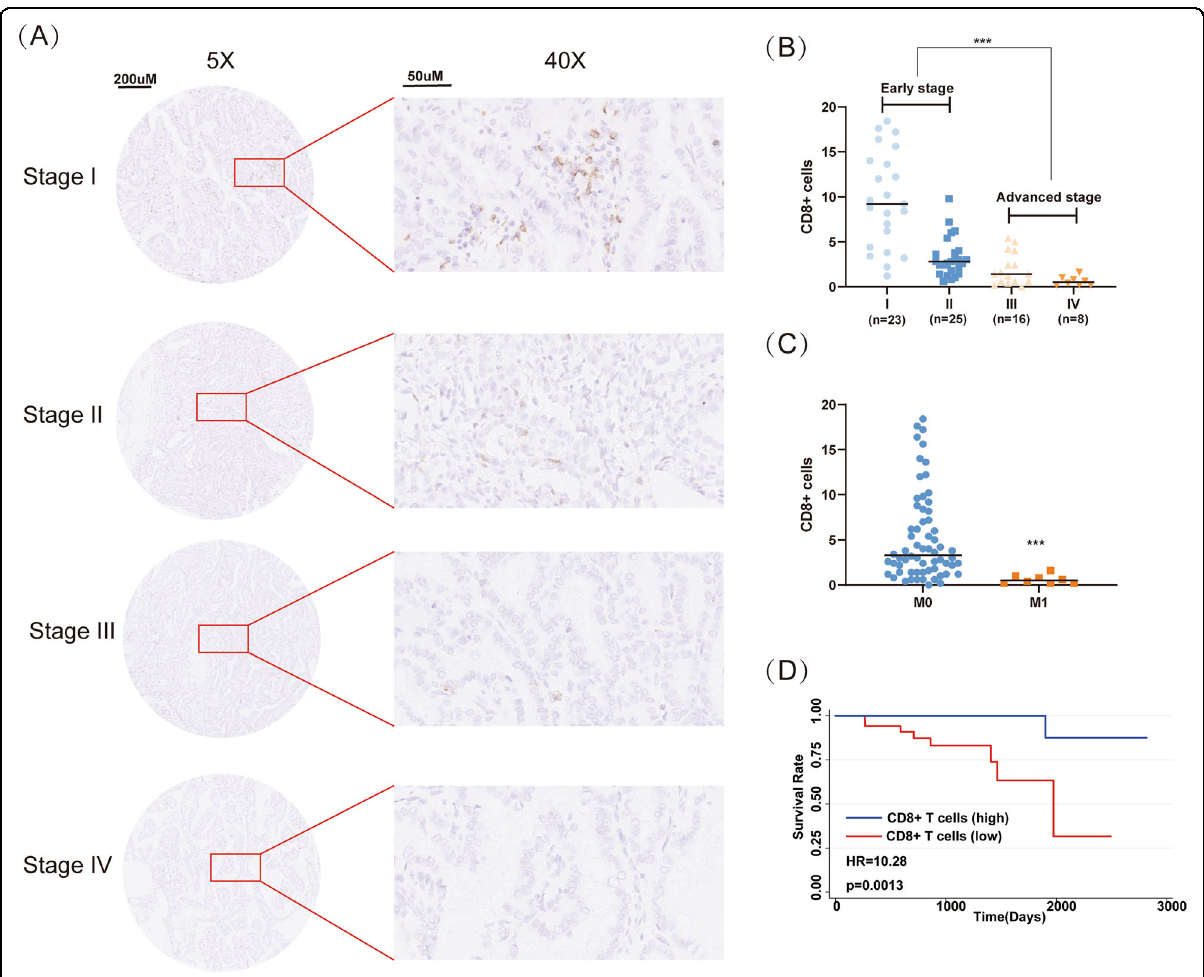
Fig. 3 Validation of CD8 + T cells in clinical specimens. A The expression of CD8 + T cells detected by IHC. B Number of CD8 + T cells in different pathological stages. C The association of CD8 + T cells and distant metastasis. D The association of CD8 + T cells and OS (patients were divided based on the median of CD8 + T